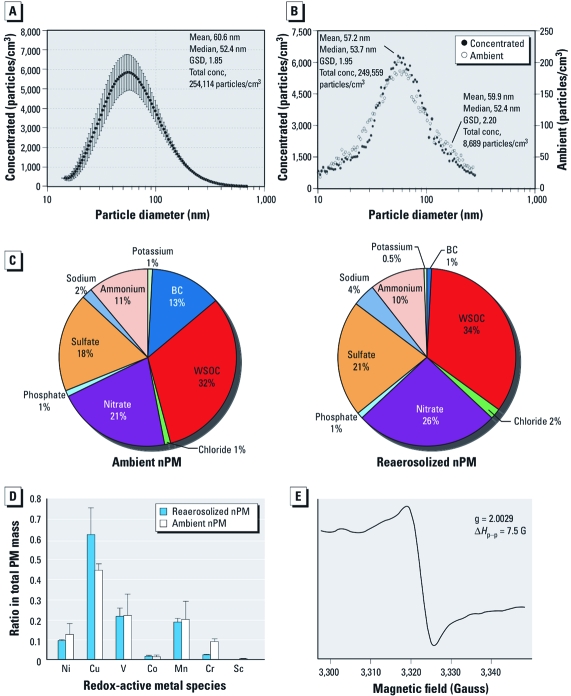
Particle size distributions for ambient and reaerosolized nPM.
Abbreviations: Co, cobalt; conc, concentration; Cr, chromium; Cu, copper, GSD,
geometric SD; Mn, manganese; Ni, nickel; Sc, scandium; V, vanadium. (A)
Average aerosol size distributions of reaerosolized nPM collected at the downtown
Los Angeles site and used in this study. (B) Average ambient and concentrated
reaerosolized nPM size distributions from the same downtown Los Angeles site.
(C) Ambient (left) and reaerosolized (right) nPM bulk chemical
composition. The mass ratios of water-soluble organic carbon (WSOC) and inorganic
ions between the two aerosols are similar, except for the lower percentage of BC in
reaerosolized nPM. (D) Redox-active metals in ambient and reaerosolized nPM.
(E) The EPR signal of nPM from urban Los Angeles vehicular traffic
collected 30 days before.